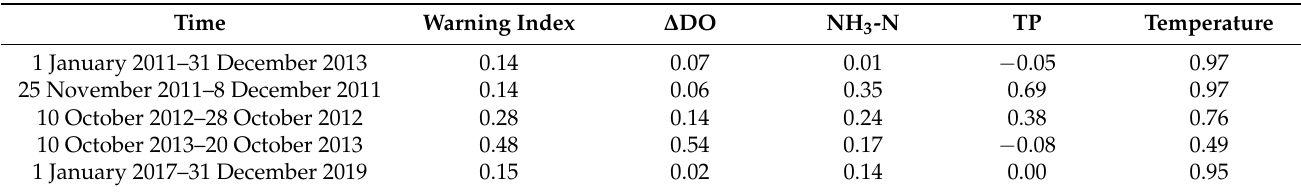
Table 4. Correlation coefficient of the warning index and driving variables of the fuzzy logic model between the PY and DC stations in different time periods.